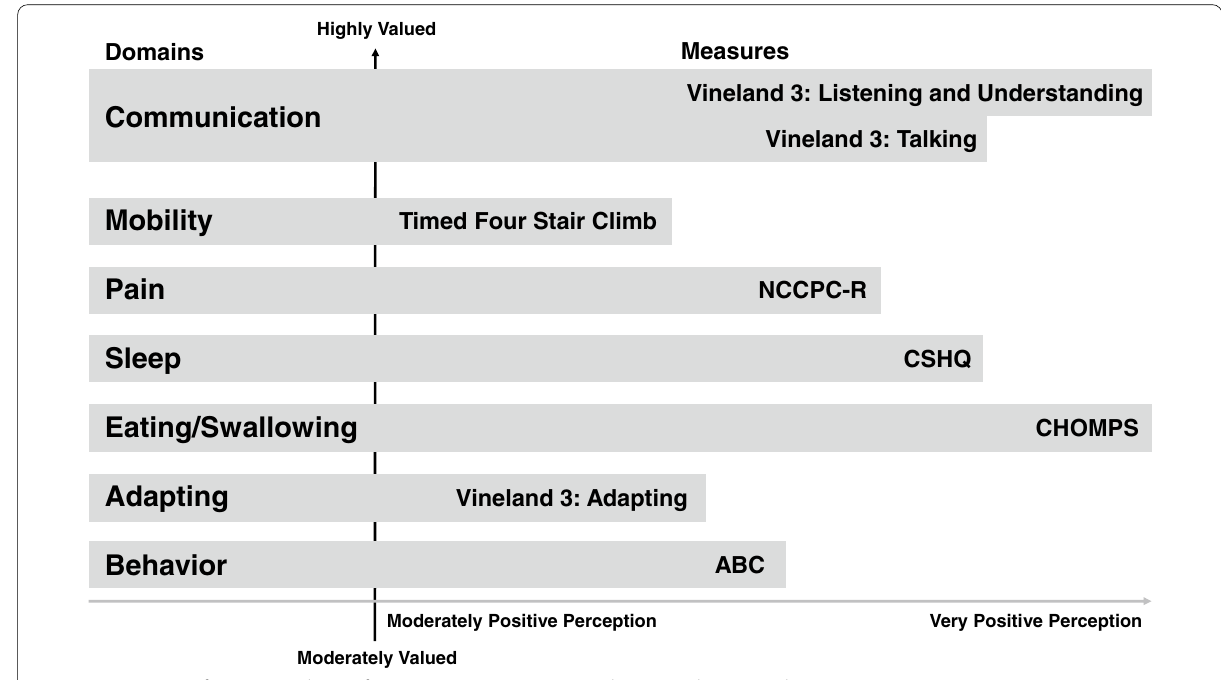
Fig. 1 Comparison of caregiver valuing of outcome measure symptom domain and